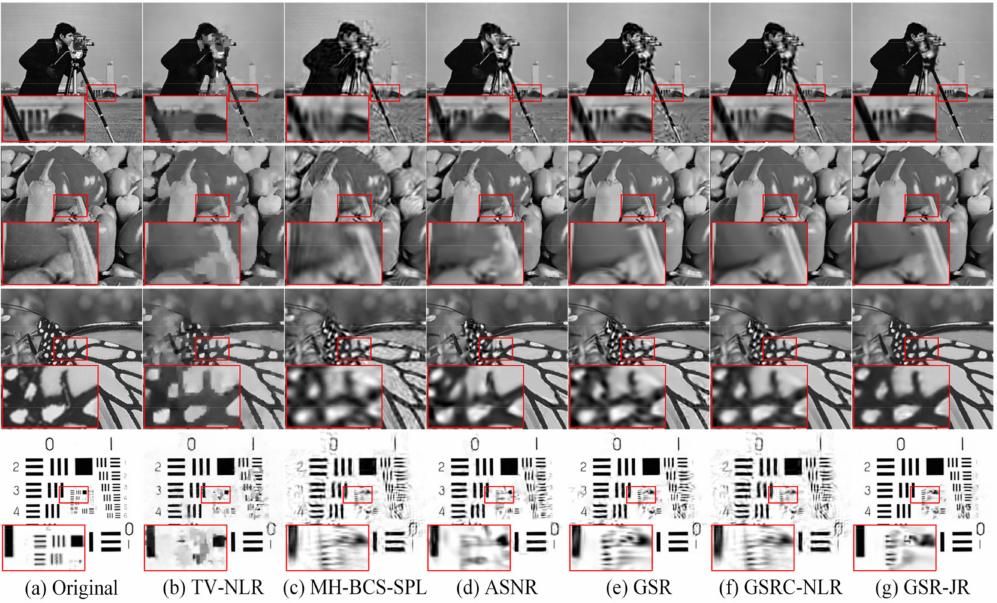
Figure 8. Visual effects of images with various reconstruction models when R = 0.1. ( a ) Original